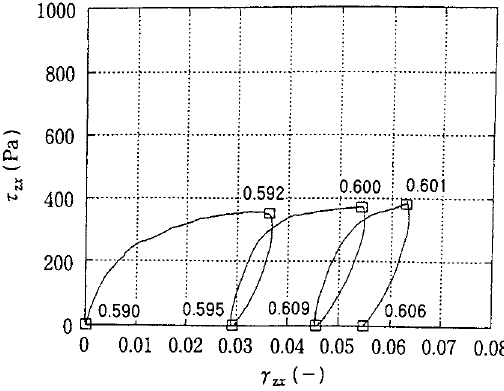
Fig. 13 . Relation between shear stress and strain ( σ zz = 990Pa)